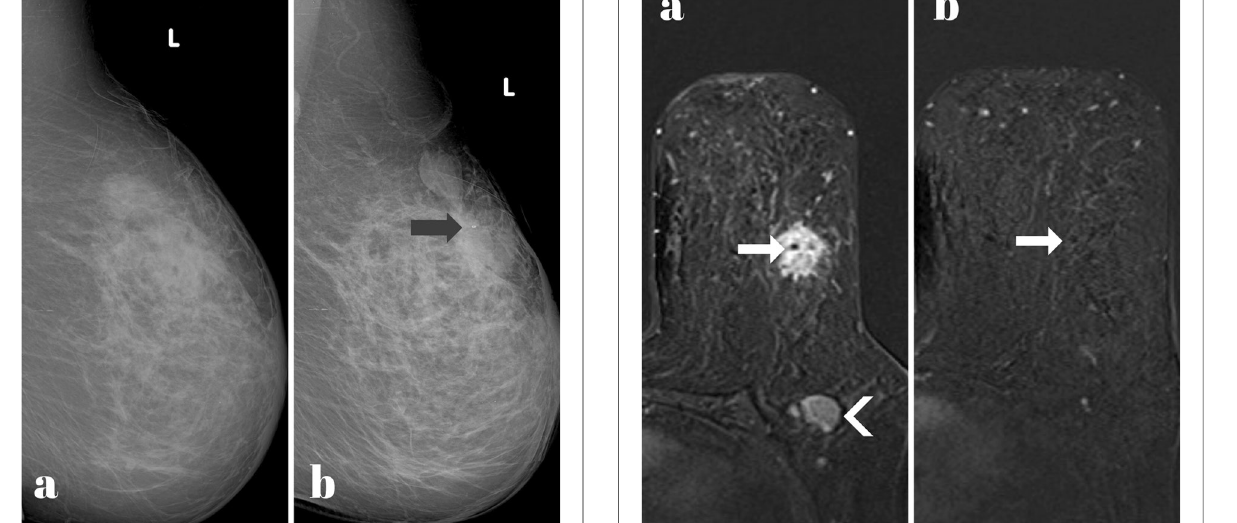
Fig. 8 Left breast T1 post‑contrast subtracted images with pathologically proved 3 o’clock axis IDC on NAC. a A signal void artifact from the inserted surgical clip is seen at the center of the mass. b Complete radiological response after completion of the NAC cycles, still with the signal void clip artifact in